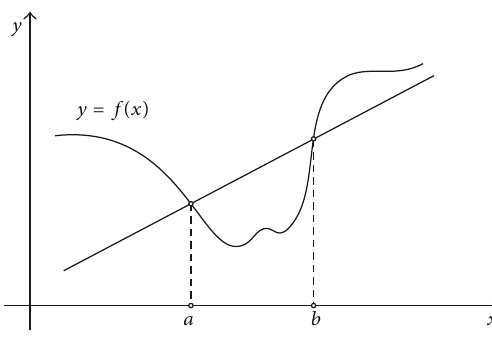
Figure 1: A continuous function satisfying